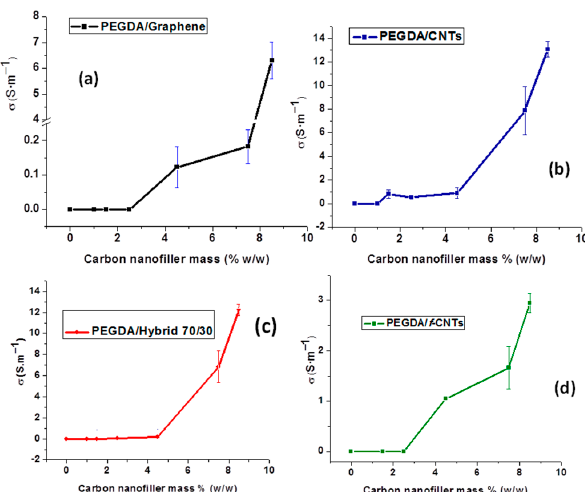
Figure 5. The σ s of ( a ) PEGDA/graphene, ( b ) PEGDA/CNTs, ( c ) PEGDA/Hybrid, and ( d ) PEGDA/ f CNTs composites as a function of carbon nanofiller percentage.